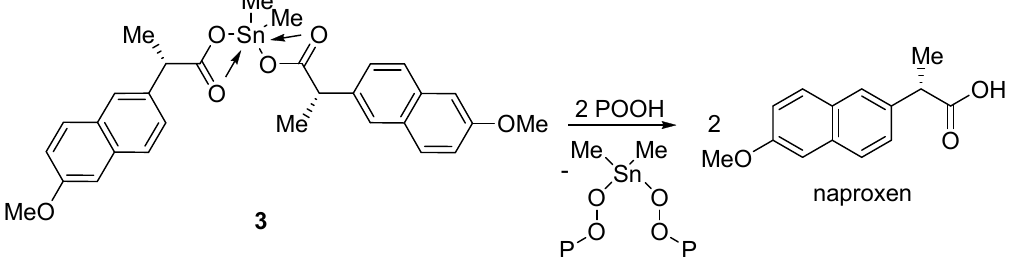
Figure 16. Diorganotin(IV) complex 3 acting as a peroxide decomposer.